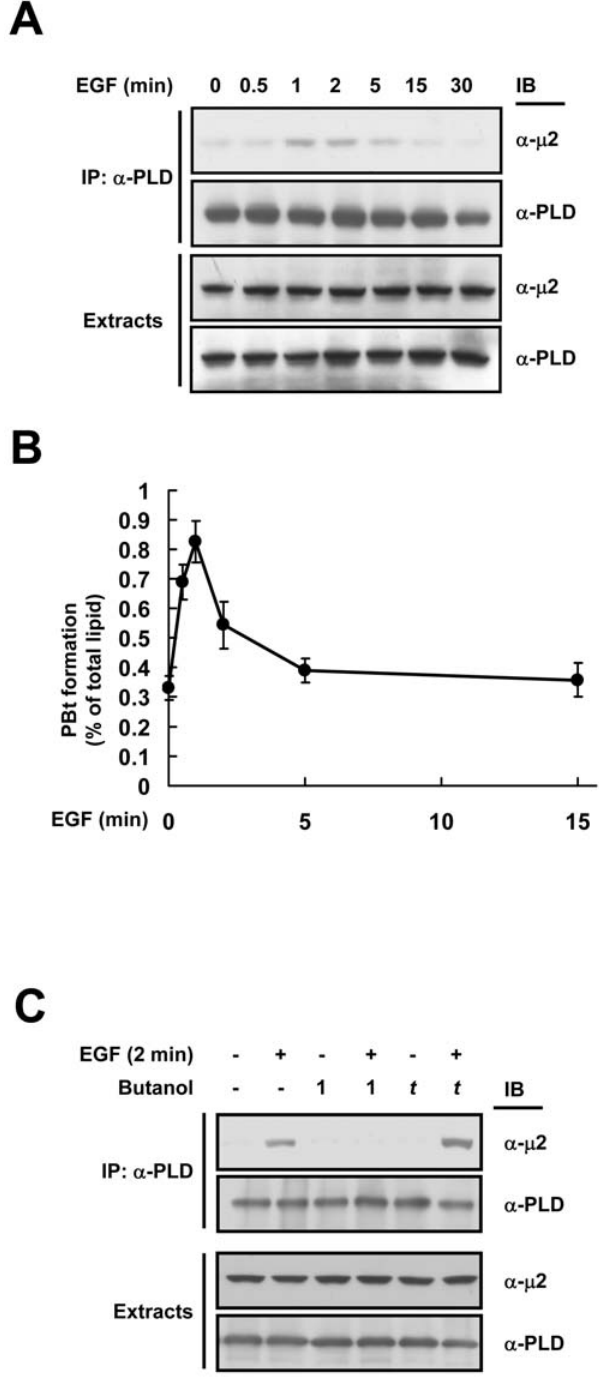
Figure 2. PLD1 associates with the m 2 subunit of AP2 in a PA- dependent manner. (A) HeLa cells were treated with EGF (20 nM) and cell extracts were immunoprecipitated with anti-PLD antibody and then immunoblotted with the indicated antibodies. (B) The kinetic of EGF-induced PLD1 activation in HeLa cells. (C) HeLa cells were treated with EGF (20 nM) for 1 min in the absence or presence of either 1- butanol (0.4%) or t -butanol (0.4%) as shown and then the cell lysates were immunoprecipitated as in (A). Alcohols were added 5 min prior to EGF treatment.